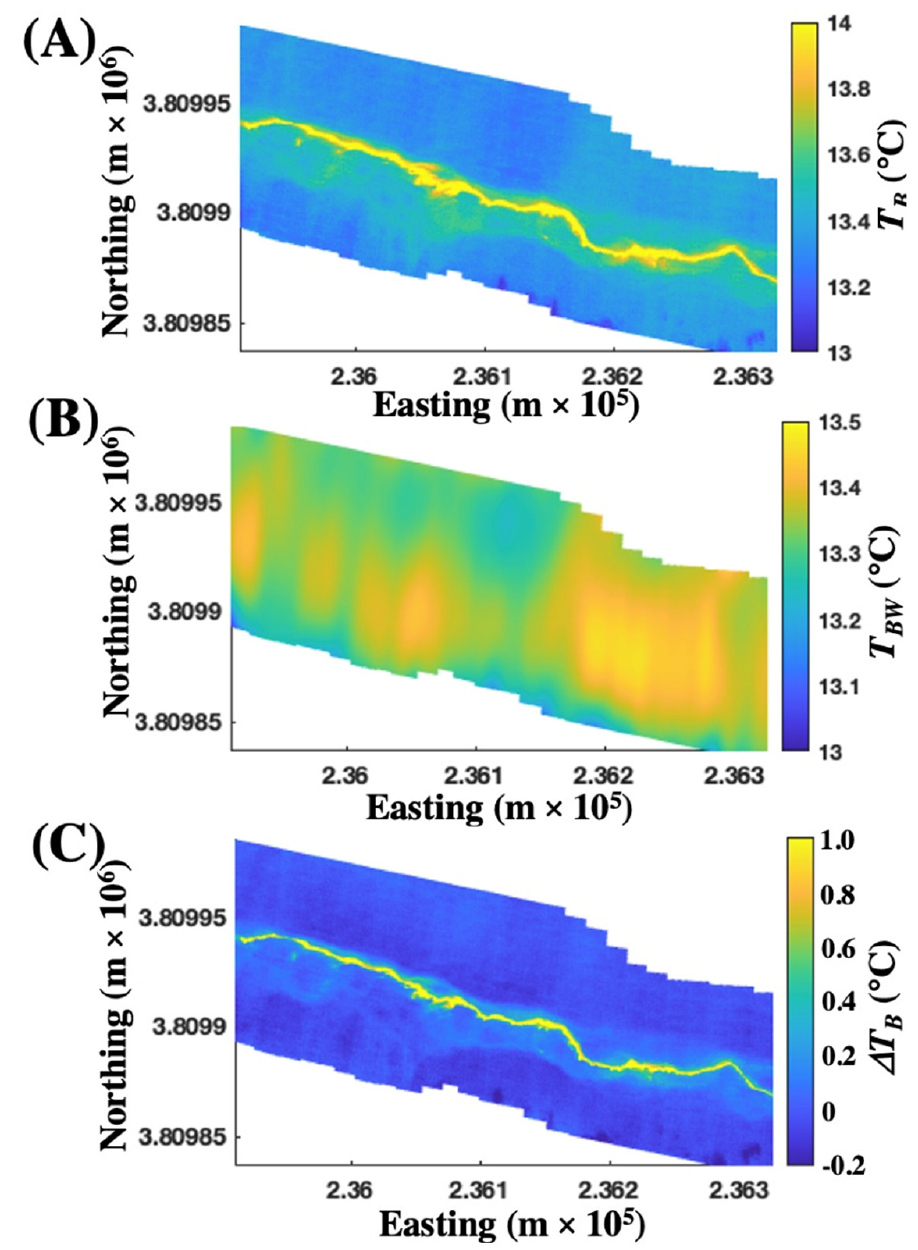
Figure 9. ( A ) Visible image photomosaic of an oil slick for 25 May 2016 oriented in the along-slick and cross-slick coordinates, X and Y , respectively. ( B ) Mosaicked thermal infrared image of sea surface brightness temperature, T B , projected to a 20-cm grid. ( C ) Water brightness temperature ( T BW ) map. Data key on the figure. Thermal structures in T BW were less pronounced on 25 May and also less associated with meanders—the structure at X = 525–675 m was an exception (Figure 10). There was also no evident thermal discontinuity across the slick, suggesting this slick was not trapped by the main eddy west of COP (Figure